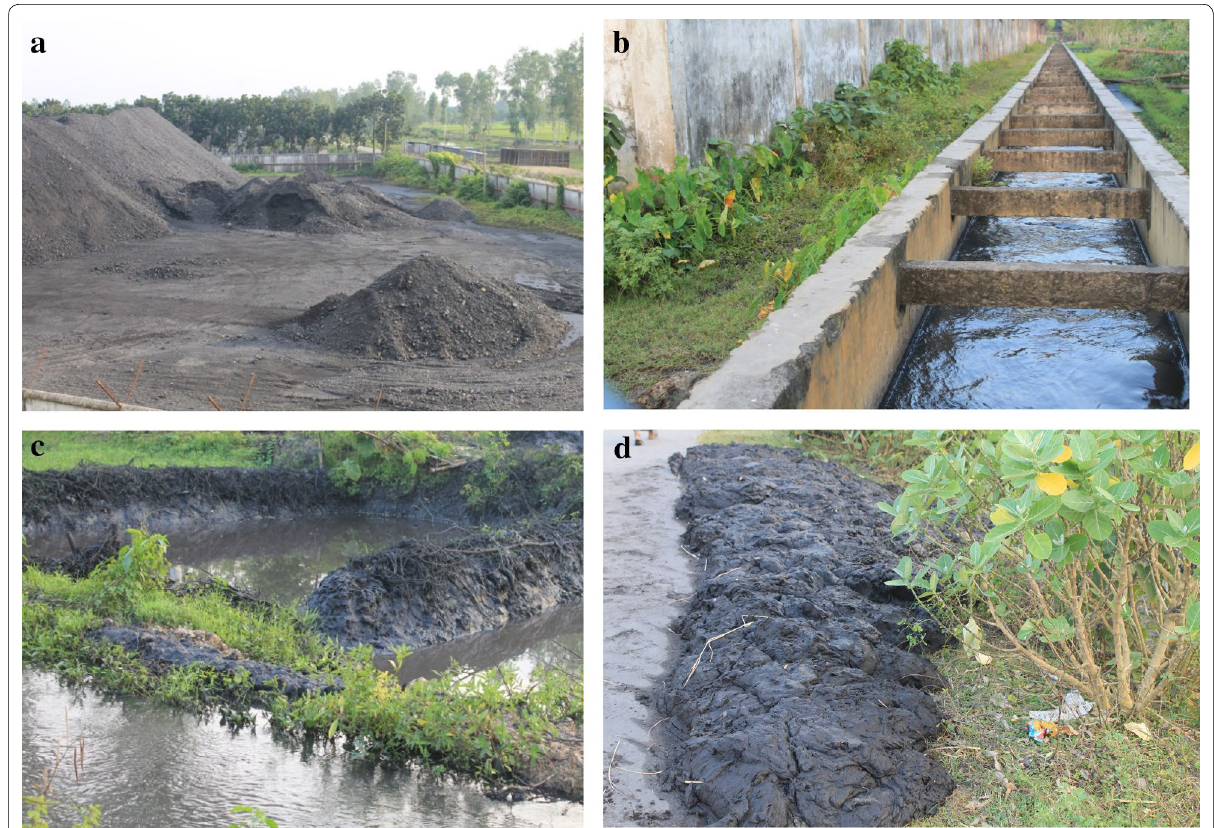
Fig. 2 The different photographs showing the ways of degrading the quality of soil around the study area. a Coal stock pile. b Drainage system. c Drainage exit of coal mine. d Soil